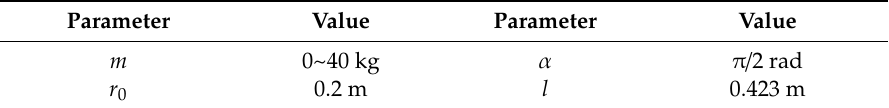
Table 2. Robot’s primitive load and center of gravity